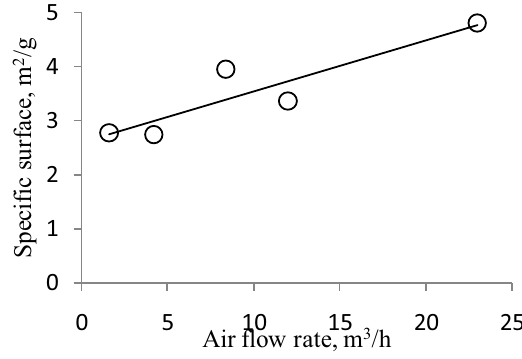
Fig. 5 . Specific surface of the obtained